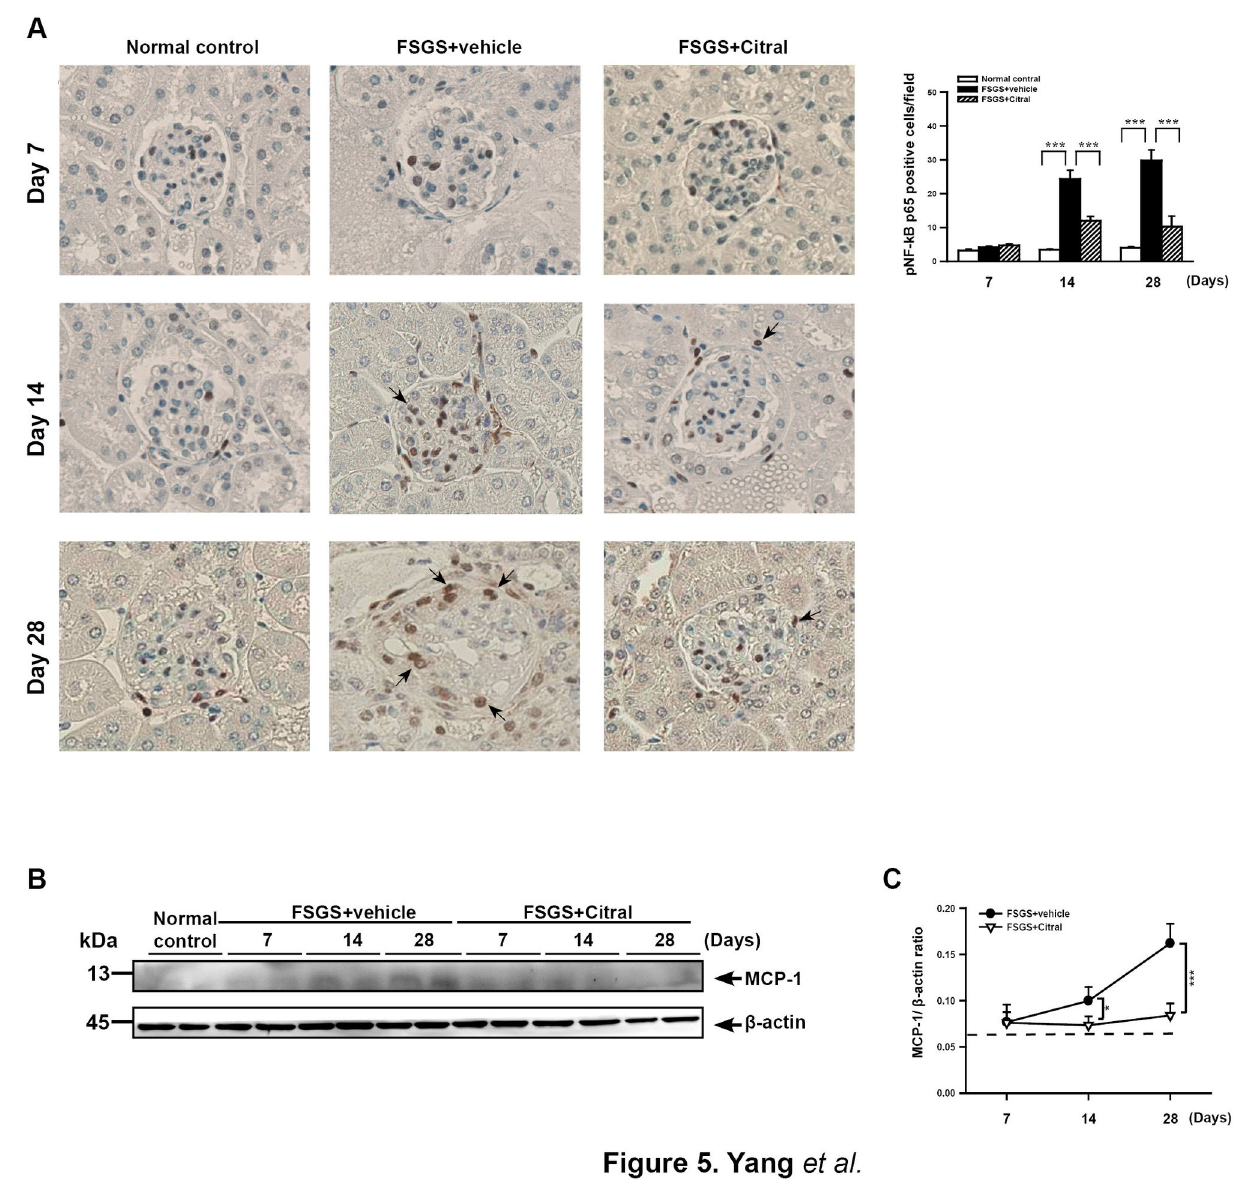
Figure 5. Renal NF-κB activation and MCP-1 expression. (A) Detection of NF-κB p65 by immunohistochemical staining. Original magnification, 400×. The arrows indicate positively stained cells. The scoring is shown on the right. (B) Western blot of MCP-1 levels in renal tissues, with β-actin as the internal control for cytosolic protein. (C) MCP-1/β-actin ratio. In the histograms, the data are the mean±SEM for seven mice per group. * p <0.05, *** p